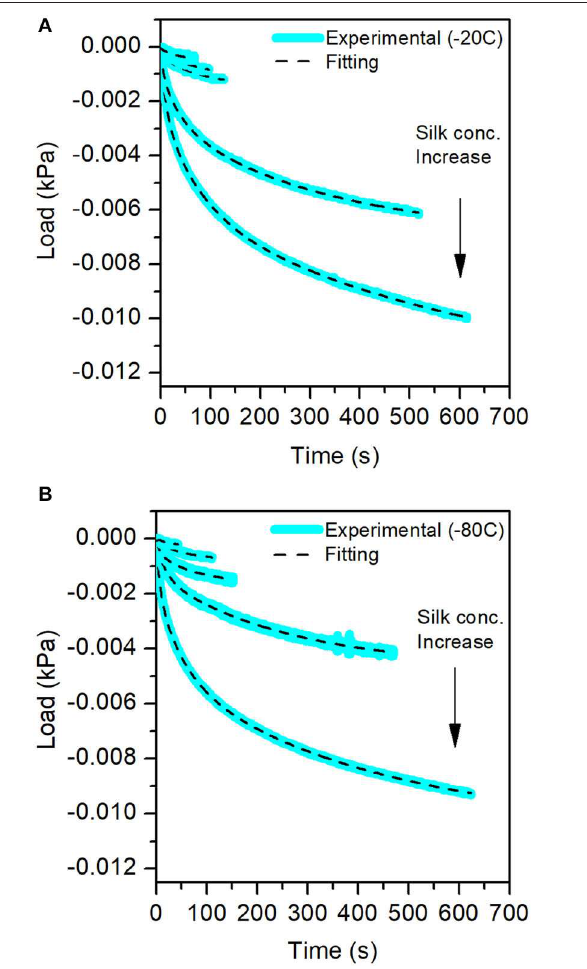
FIGURE 9 | Stress-Relaxation curves obtained from the mechanical test for the different sponge scaffolds. In blue, the experimental data, and in the dash lines, the fits. (A) At − 20 ◦ C and (B) at − 80 ◦